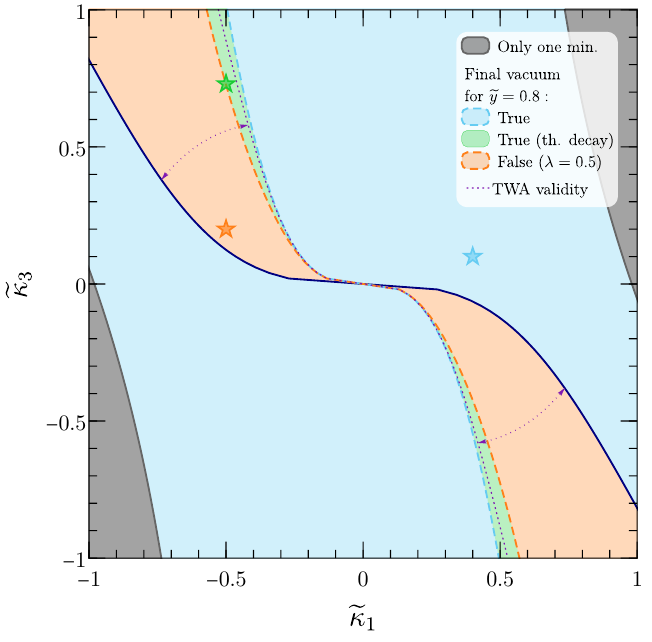
Figure 6 . Parameter space for the (cid:12)eld (cid:30) where it can settle either to its true vacuum (blue and green regions) or false vacuum (orange region) in the thermal history of the Universe. The parameters (cid:20) 1 , (cid:20) 3 , y , (cid:21) are de(cid:12)ned in eq. (3.1) and table 1. In the regions which are not shaded e e e in grey in this plot, V ( (cid:30) ) displays two non-degenerate minima. Depending on the solution to the measure problem, (cid:30) during in(cid:13)ation was either in its false or in its true vacuum. If (cid:30) resided in its false vacuum during in(cid:13)ation, then the blue and green regions of this plot realise the mechanism shown respectively in (cid:12)gure 1 and 4 (for the points marked respectively by blue and green stars) and (cid:30) eventually settles in the true vacuum, which has an opposite sign with respect to in(cid:13)ationary one. If instead (cid:30) was in its true vacuum during in(cid:13)ation, then the orange regions of this parameter space realise the evolution shown in (cid:12)gure 3 (corresponding to the point marked by the orange star). Therefore, independently of the solution to the measure problem there is a fraction of order one (orange region, 20% in this (cid:12)gure) of the parameter space of (cid:30) where the (cid:12)eld (cid:30) can start from the lower energy minimum during in(cid:13)ation and ends in the false vacuum today, and another fraction of order one (blue and green region, 80% in this (cid:12)gure) of the parameter space of (cid:30) where the (cid:12)eld (cid:30) can start from the higher energy minimum during in(cid:13)ation and ends in the true vacuum today. In all cases, that is, all coloured regions, the axion (cid:12)eld has an initial misalignment angle close to (cid:25) . The di(cid:11)erence between blue and green regions is that, in the latter case, (cid:30) was initially rolling to the false vacuum during the thermal phase, but then thermally decayed to the true vacuum, as shown in (cid:12)gure 4. This calculation is performed using the thin-wall approximation (TWA), whose regime of validity is shown by the purple dotted arrows in this plot.